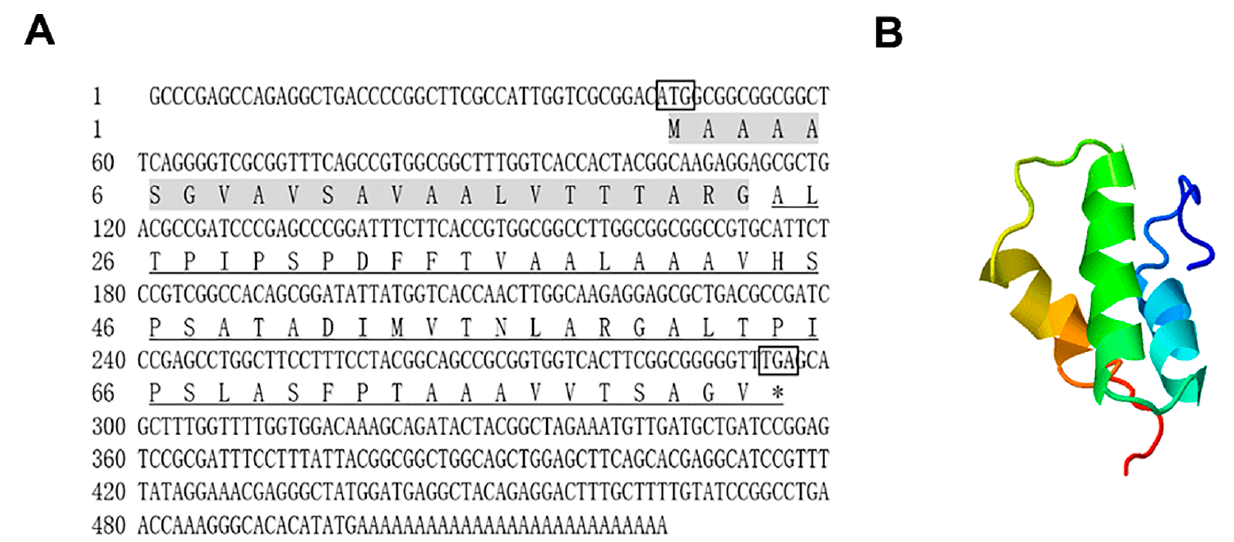
Figure 1. Bioinformatics analysis of Sparanegtin. The cDNA and deduced amino acid sequences of Sparanegtin: the boxed sequence represents the initiation codons; the boxed sequence and “*” represents the stop codons; the predicted signal peptide is shaded; underline regions indicate the mature peptide ( A ). The protein structure of Sparanegtin mature peptide was predicted by I-TASSER server ( B ).